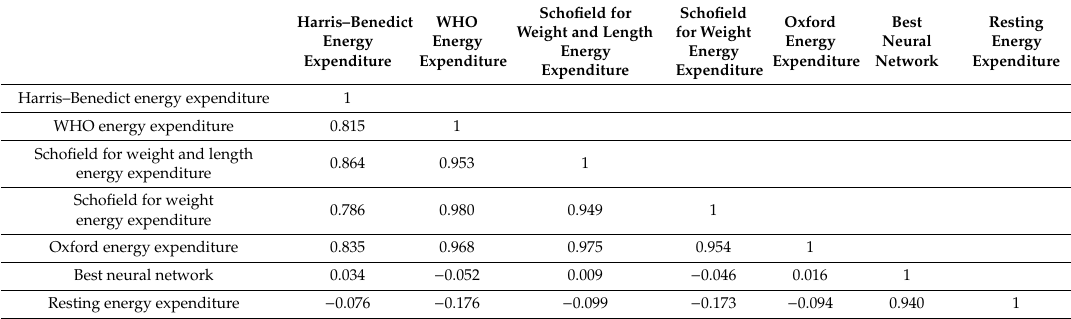
Table 3. Matrix of linear correlation among equations’ outputs each